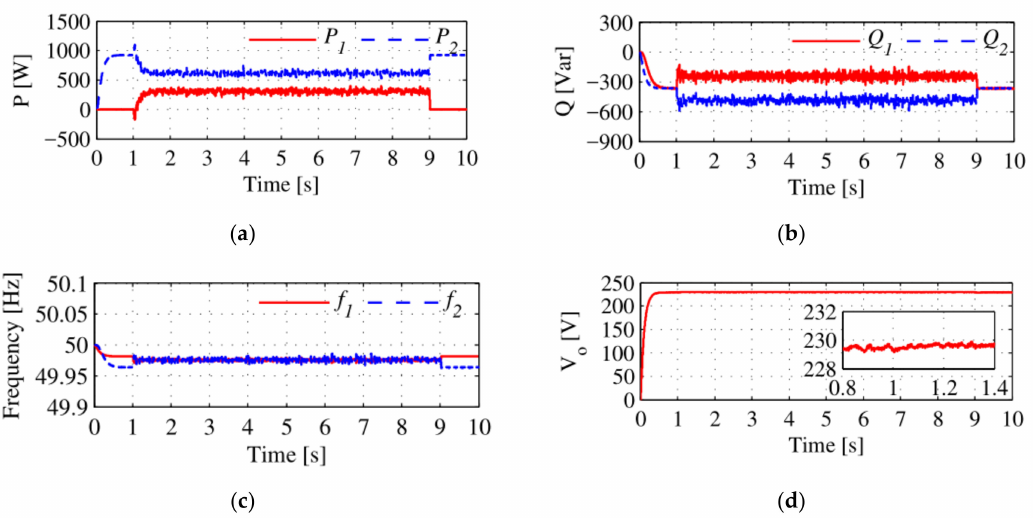
Figure 8. Power sharing in the first scenario considering inductive feeder impedance; ( a ) output active powers of DGs, ( b ) output reactive powers of DGs, ( c ) output frequencies of DGs, ( d ) terminal DGs